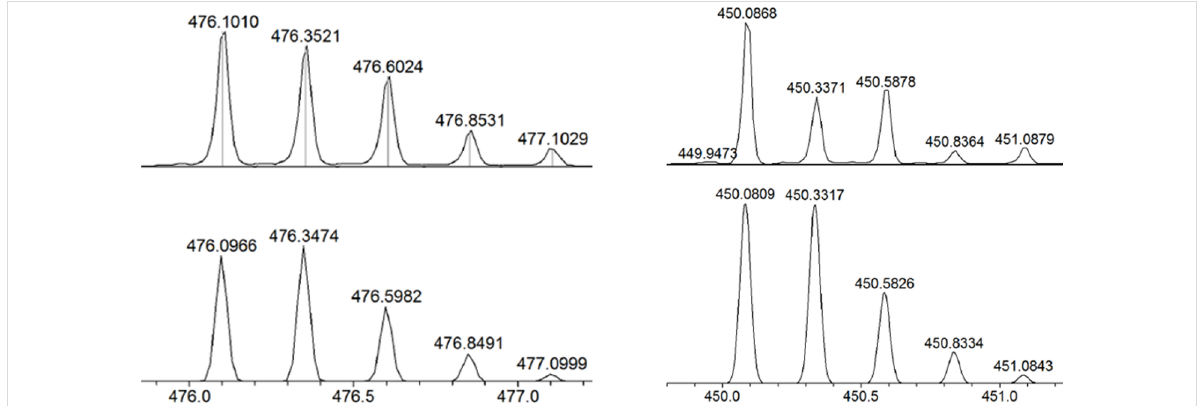
Figure 3: Calculated (bottom) and experimental (top) ESI-MS spectra of the tetracationic half-sandwich rhodium metallarectangles [ 3a – 4OTf] 4+ (left) and [ 3b – 4OTf] 4+ (right).